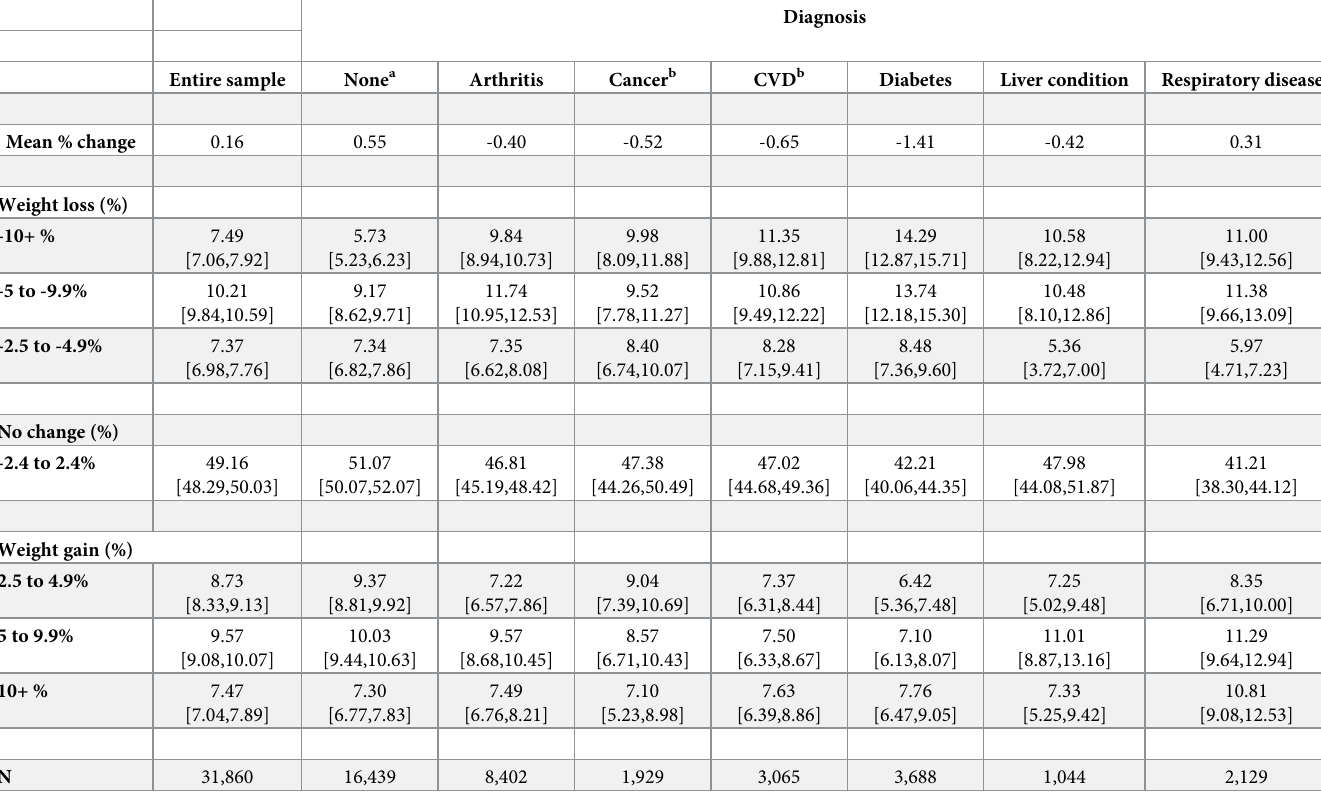
Table 2. Percent weight change in the last year for those diagnosed 2+ years ago. Adults 30+, NHANES 1999–2014. 95% confidence interval in brackets.